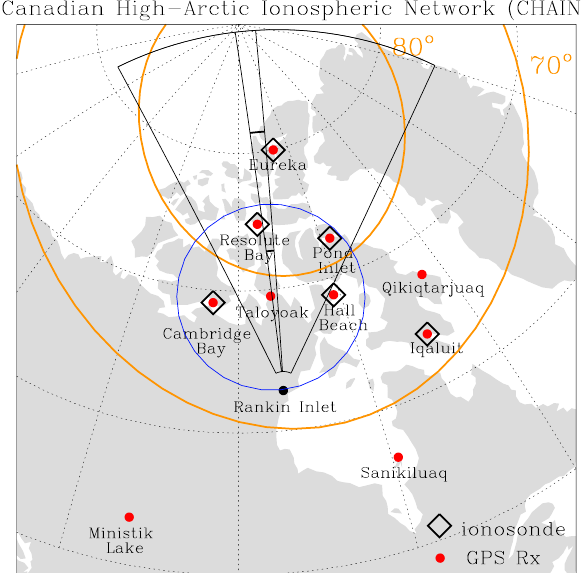
Fig. 1. Canadian High Arctic Ionospheric Network. SuperDARN Rankin Inlet radar field of view with beam 6 up to 3200km range and the NORSTAR Taloyoak all-sky imager field of view are su- perposed. Corrected geomagnetic (CGM) latitudes 70 ◦ and 80 ◦ are